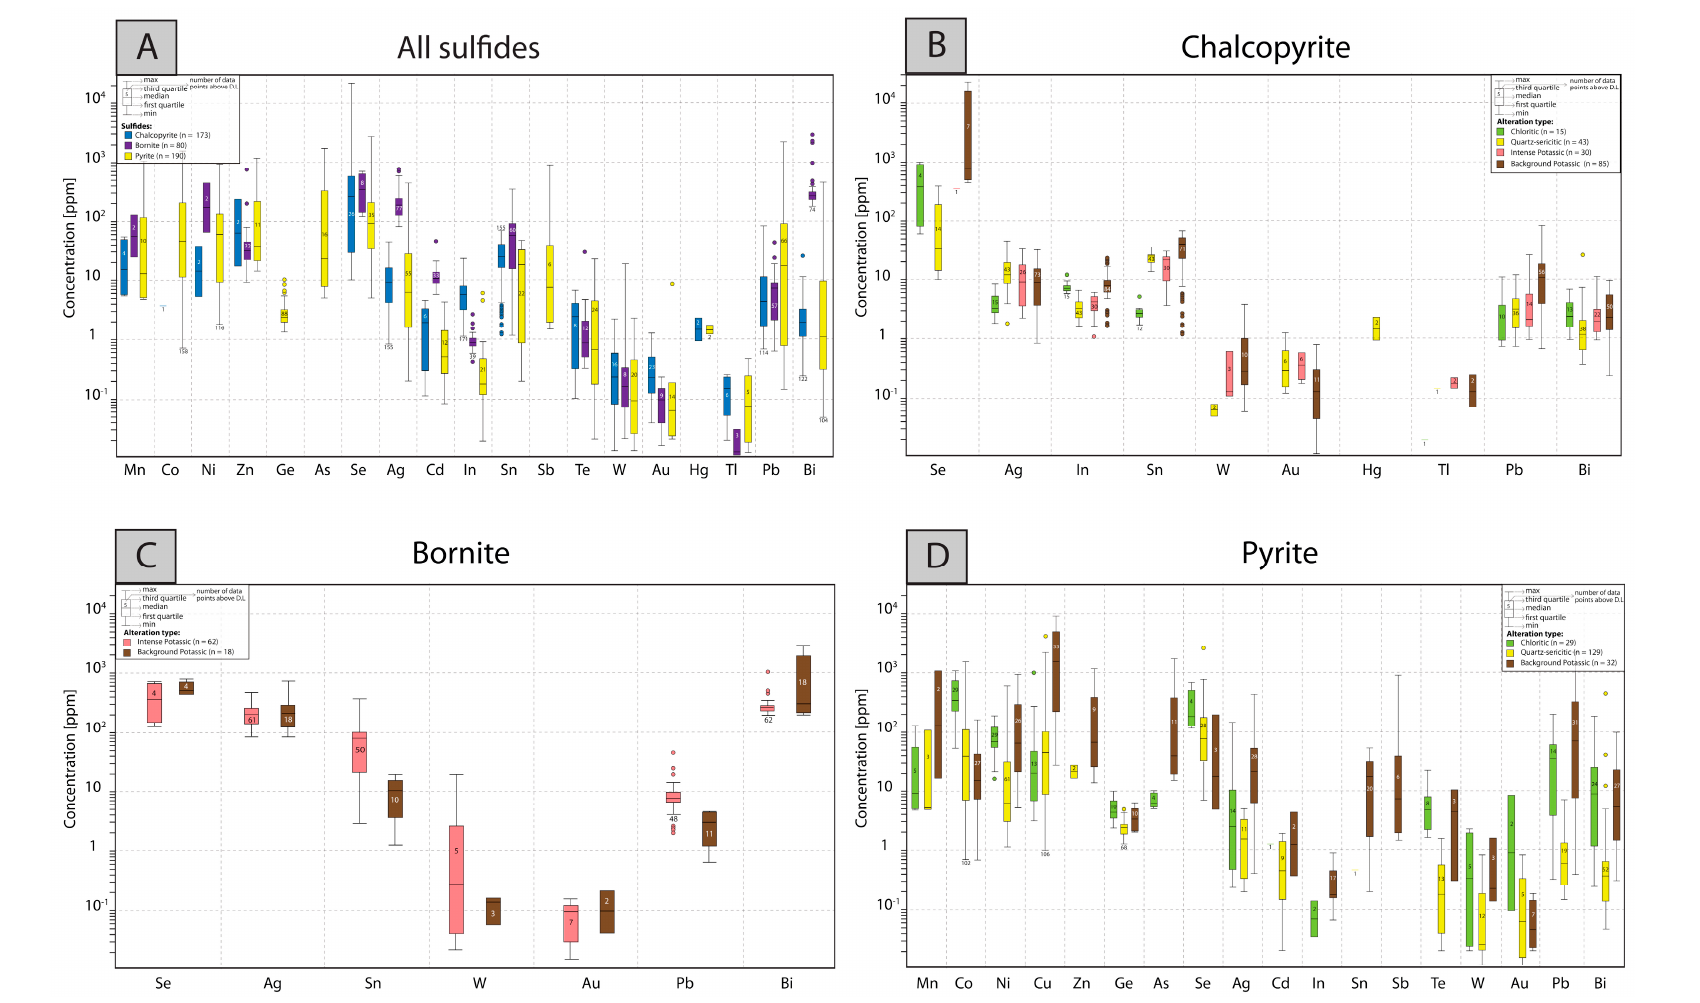
Figure 7. Concentration plot for minor and trace elements in sulfides from the Chuquicamata Underground mine. Data are plotted in parts per million (ppm) on a vertical logarithmic scale. In each boxplot, minimum, median, and maximum concentrations are indicated, and the number of analyses above detection limit for each element is displayed inside each box. ( A ) Boxplot of LA-ICP-MS data for selected minor and trace elements detected in all sulfides (chalcopyrite, bornite, and pyrite). ( B – D ) Boxplots of LA-ICP-MS data for selected minor and trace elements in chalcopyrite, bornite, and pyrite, respectively, from different alteration zones in the Chuquicamata Underground